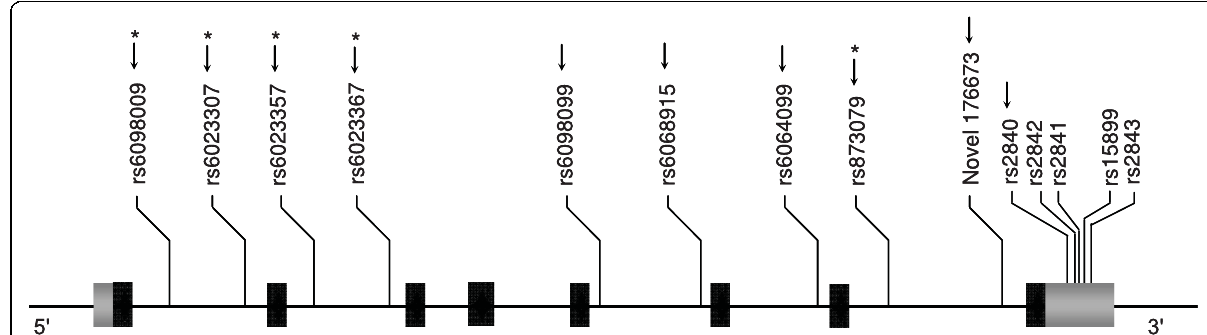
Figure 1 Gene structure of DOK5 representing SNPs identified in Indian population and selected for association analysis . SNPs marked with arrow were selected for association analysis. * indicates the SNPs selected from NCBI variation databases while other SNPs were identified by direct sequencing of the